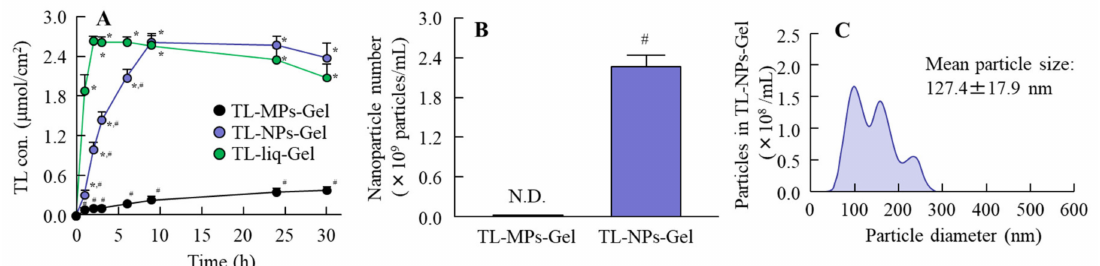
Figure 4. TL release from TL formulations through membranes. ( A ) TL release from TL formulations Table 220. nm pore membranes. ( B ) and ( C ) nanoparticle number (B) and size distribution (C) of TL in the reservoir chamber 24 h after the application of TL-NPs-Gel. TL-MPs-Gel, formulation containing TL microparticles. TL-NPs-Gel, formulation containing TL nanoparticles. TL-liq-Gel,